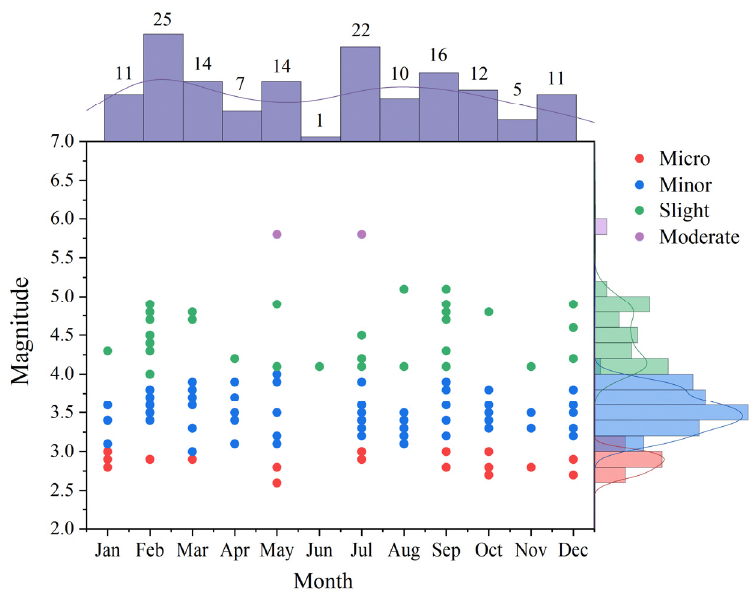
Figure 5. Number of earthquakes monthly for the year 2017. The upper part of the graph represents the distribution of quantity, while the right side represents the distribution of the seismic frequency by magnitude according to the USGS